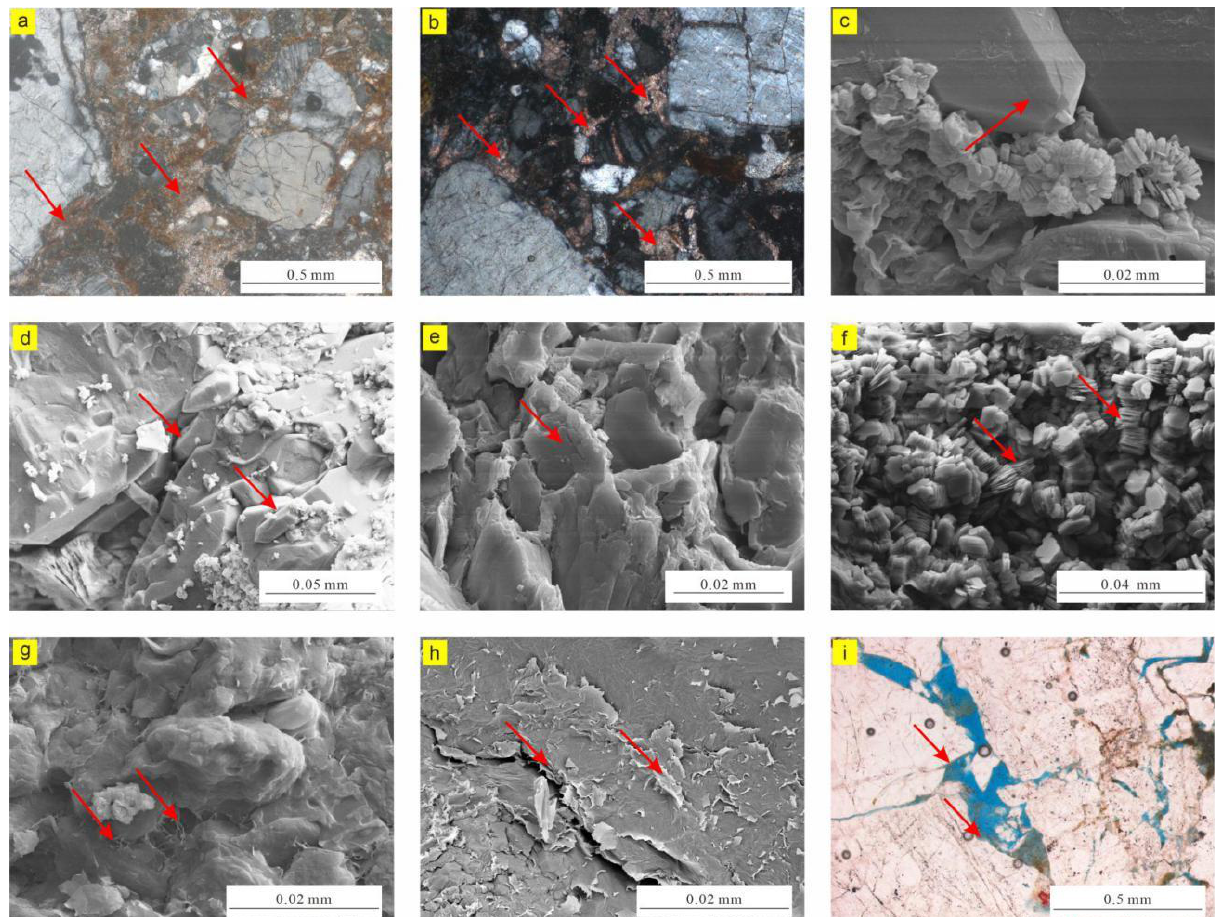
Figure 7. Characteristics of cementation in Lower Jurassic reservoir in the Niudong area: ( a ) N101, 3622.1 m, calcite with basal cement; ( b ) N104, 2364.9 m, calcite with porous cementation; ( c ) N1-2-1, 1975.2 m, quartz overgrowth in Ⅲ grade; ( d ) N102, 2113.8 m, quartz overgrowth degree of grade Ⅲ ; ( e ) N1-2-1, 1966.9 m, kaolinite on particle surface; ( f ) N102, 2020.5 m, page-shaped kaolinite filling intergranular pores; ( g ) N106, 2836.5 m, filaments of illite; ( h ) N104, 2369.7 m, illite/smectite mixed layer on particle surface; ( i ) N102, 2117.2 m, chlorite films.